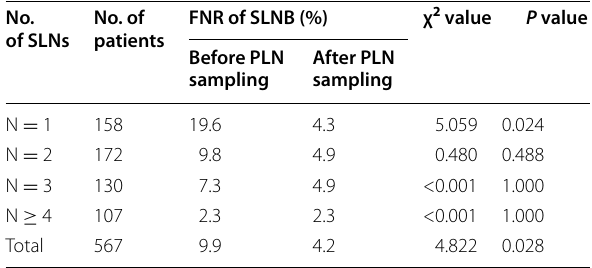
Table 4 FNR comparison before and after PLN